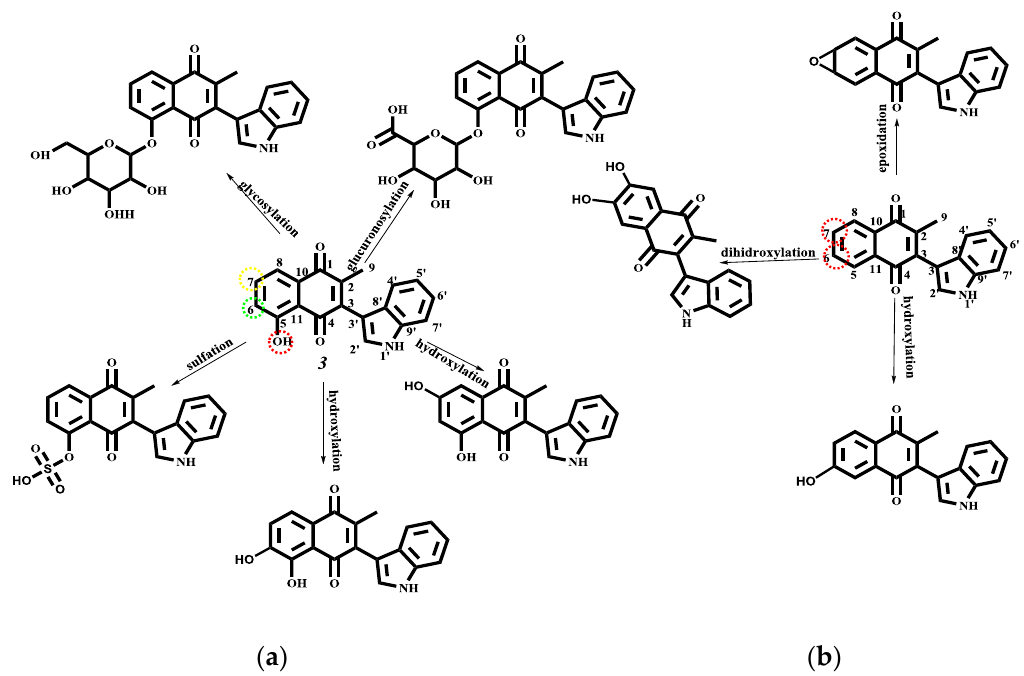
Figure 15. Predicted metabolism for: ( a ) indolylplumbagine ( 3 ) and ( b ) indolylmenadione ( 4 ).